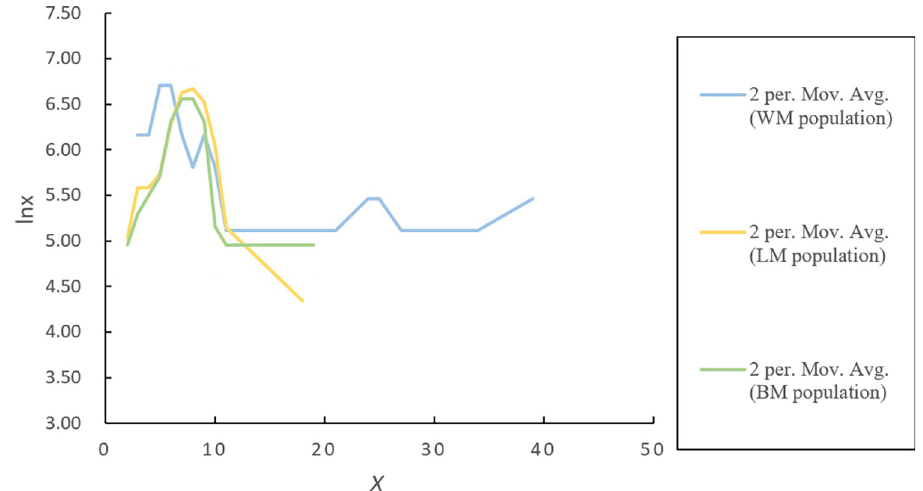
Fig 6. Mortality curves of three P . flavus populations.